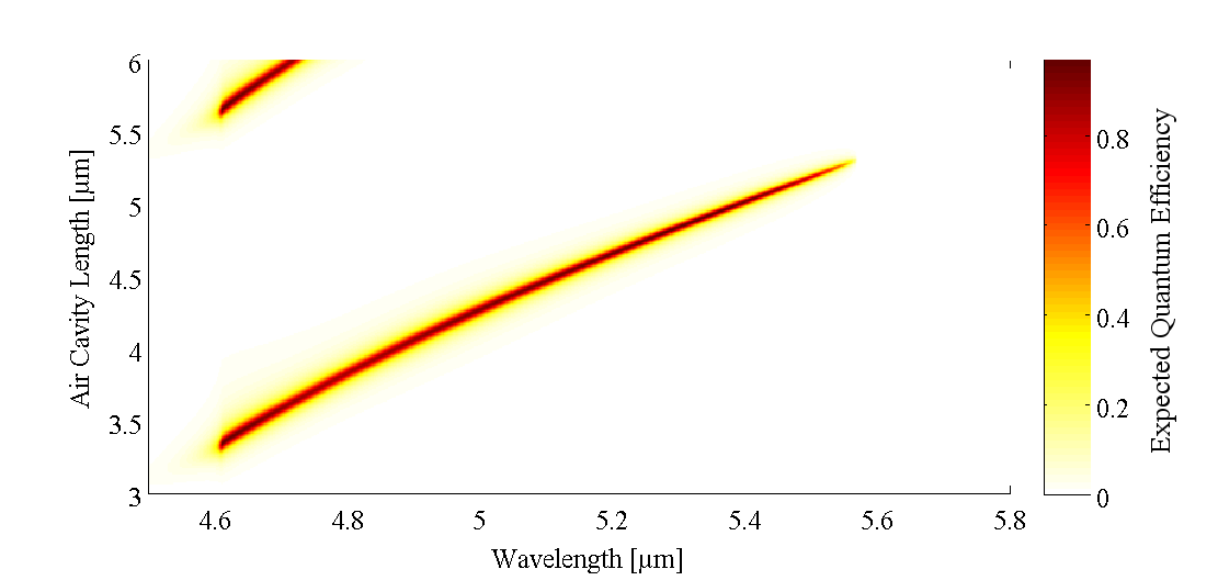
Figure 2: Detector quantum efficiency simulated for perpendicular incident radiation at 100 K using the transfer matrix method. Displacing the movable MEMS mirror allows changing the air cavity length and thus the detection wavelength. At a certain mirror position, the detector is sensitive at a single narrow wavelength band only. Shorter wavelengths are absorbed in a buffer layer while longer wavelengths are above the designed cut-off of the